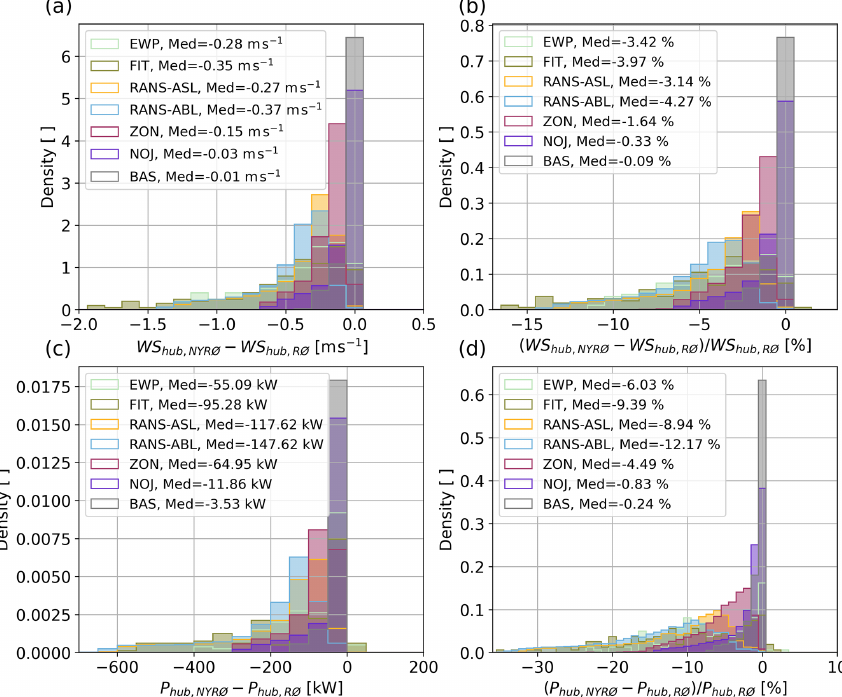
Figure 15. Histogram of reduction in (a, b) wind speed (WS) and (c, d) power ( P ) at hub height in the area of Rødsand II (solid rectangle around Rødsand II in Fig. 2) due to the presence of Nysted in terms of (a, c) absolute differences and (b, d) relative